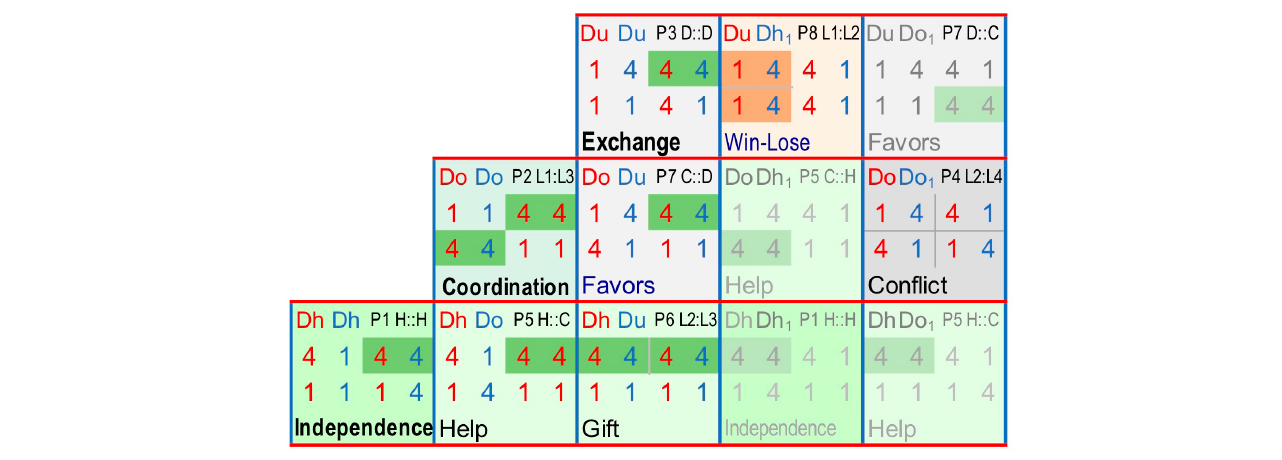
Fig. 2. Primal archetypes. Payoff patterns from three symmetric primal archetypes for exchange, coordination, and independence combine to form asymmetric archetypes. Each row has the same payoffs for the row actor and each column has the same payoffs for the column actor. Changes in the ranking of outcomes link neighboring games, i.e., swapping a “1” and a “4.” Matrices for variants that are equivalent by interchanging rows, columns, or positions are omitted or payoffs are shaded in gray and are discussed further in Appendix